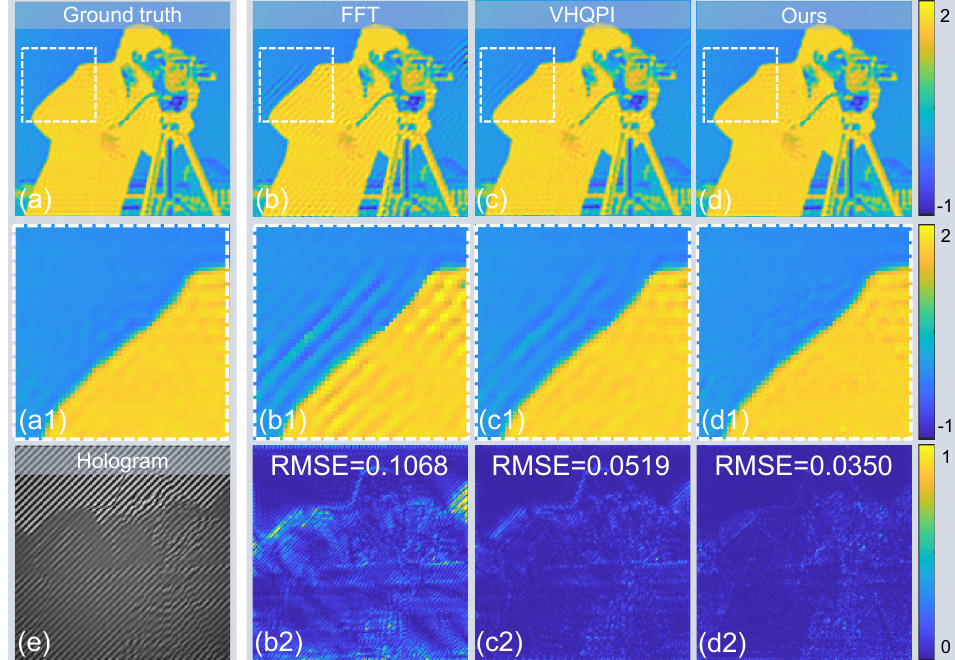
Figure 3. The experiment results under the numerical simulation. ( a ) The ground truth. ( b ) The phase result recovered by the FFT method. ( d ) The phase result recovered by the VHQPI. ( d ) The phase result of our method. ( a1 , b1 , c1 , d1 ) The local amplification results of ( a – d ). ( e ) The simulated low-carrier-frequency hologram. ( b2 , c2 , d2 ) The difference between the phase results of the three methods (i.e., FFT, VHQPI, Our method) and the ground